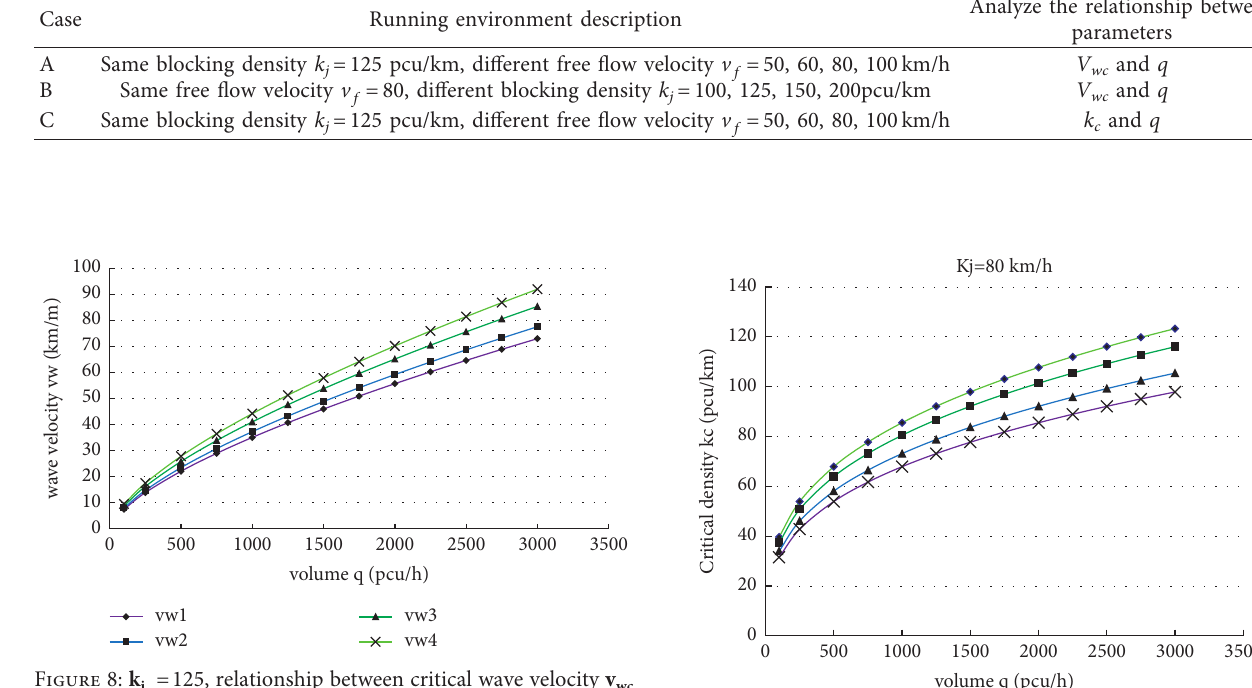
wc Figure 10: The critical density k